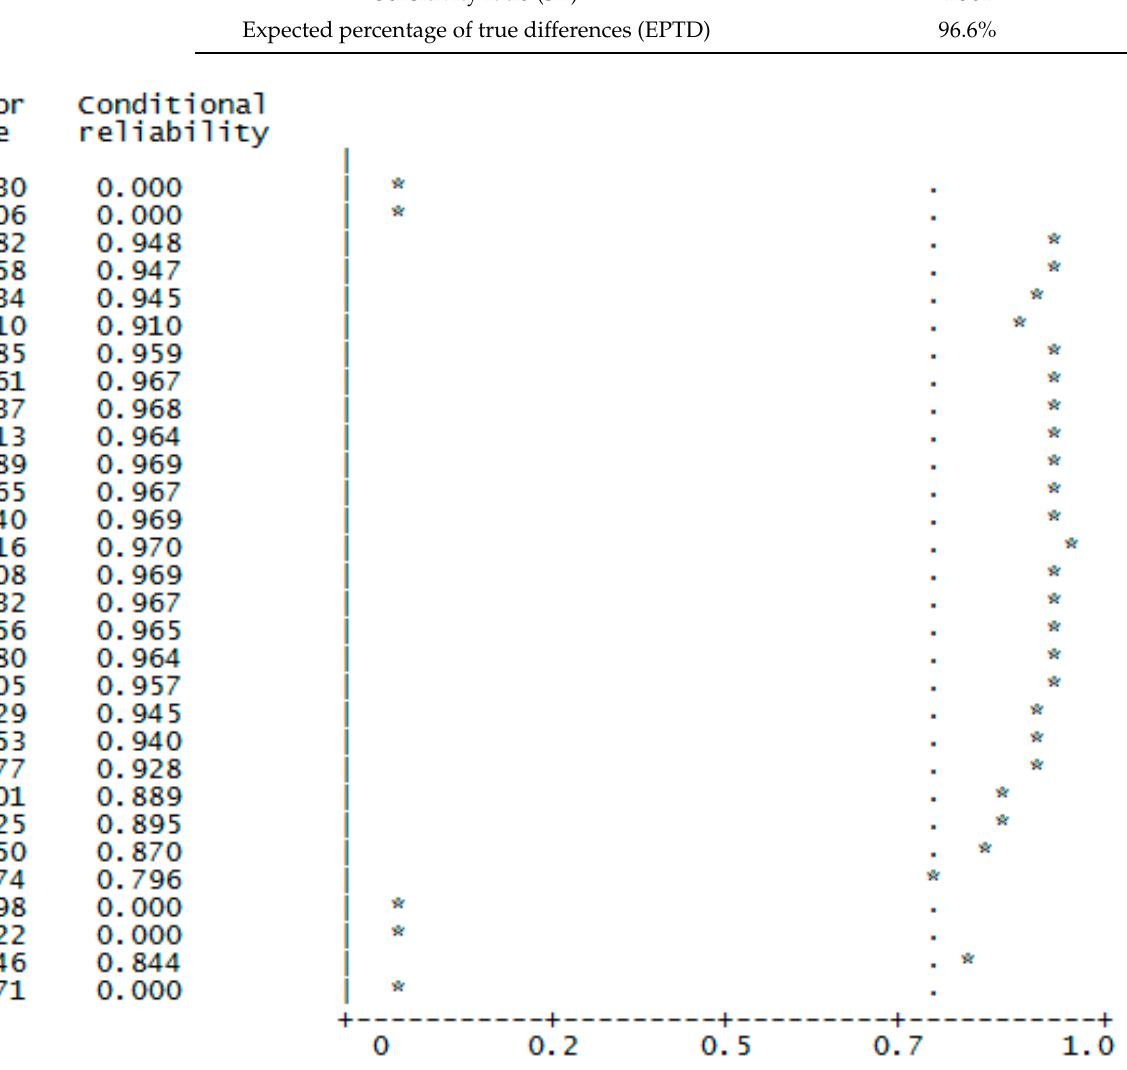
Figure 1. Distribution of conditional Bayes expected a posteriori estimation (EAP)/Orion reliability for the factor scores of the unidimensional WSCS.